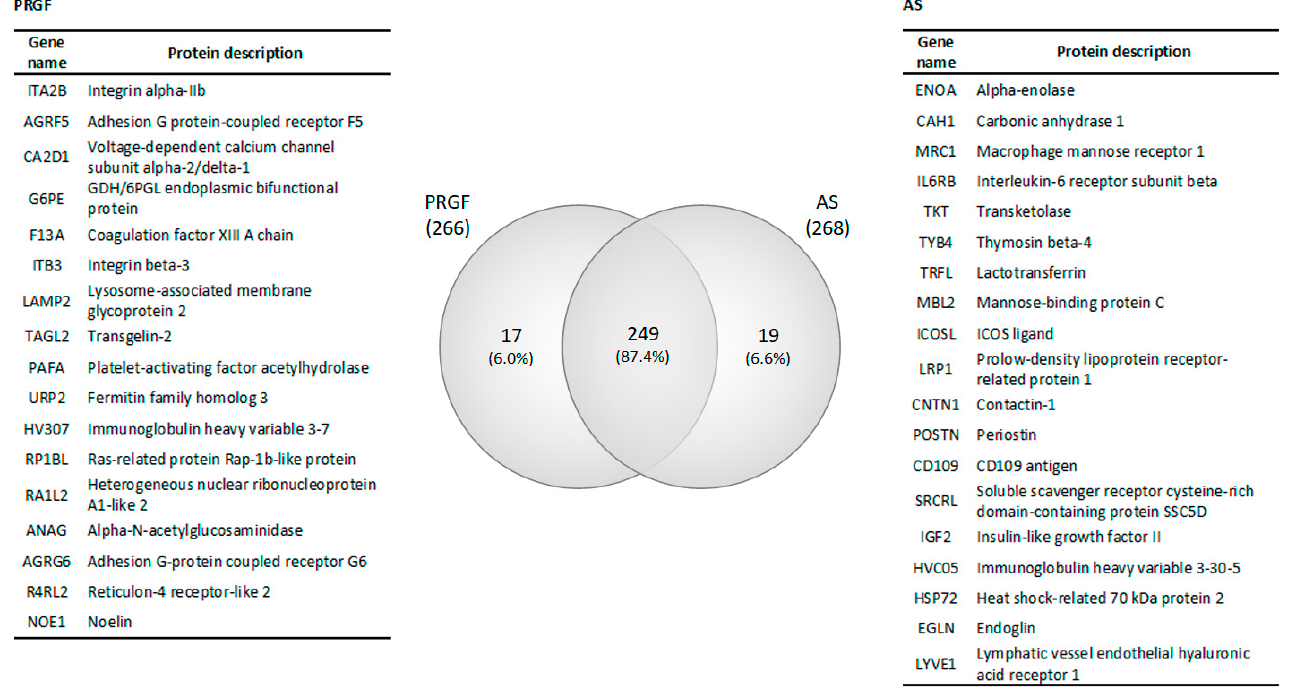
Figure 1. Venn diagram comparison of two blood-derived fractions and the list of proteins specific for PRGF and AS.